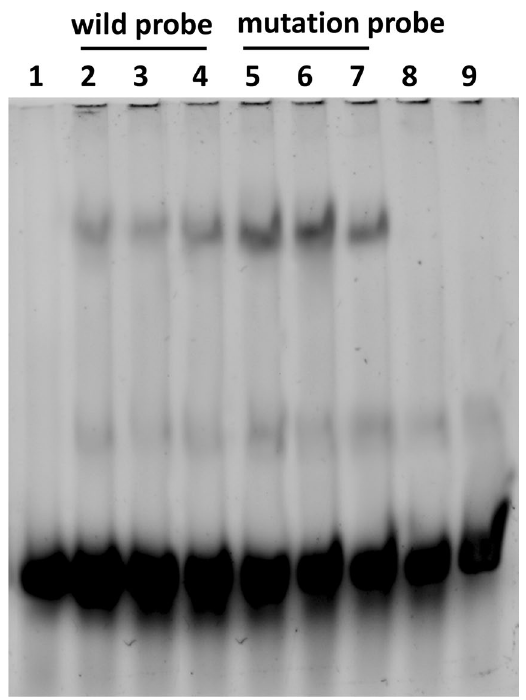
Figure 6. Characterization of the protein binding site for the SNP site, G/A (chr14:2553998), revealed in EMSA experiments. ( A ) Lane 1 = blank; Lanes 2, 3, 4 = nuclear extract + biotin-labeled Probe-wild type; Lanes 5, 6, 7 = nuclear extract + biotin-labeled Probe-mutant type; Lane 8 = nuclear extract + 100 times of cold Probe-wild type; Lane 9 = nuclear extract + 100 times of cold Probe-mutant type. The probes with the mutant allele showed higher nuclear protein affinity than the probe with the wild-type